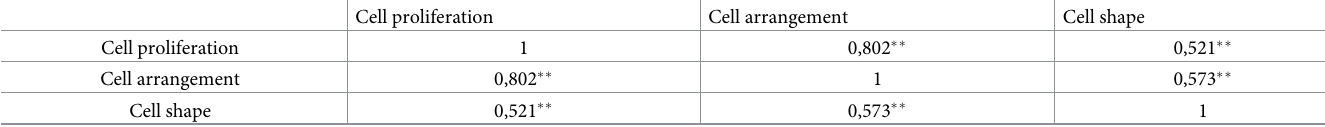
Table 2. Pearson correlation coefficients for different phenotypic parameters at early stages of development. Cell proliferation, cell arrangement and cell shape were evaluated in 65 seedlings of ‘Moniqui’ X ‘Paviot’ (MXP) F1 apricot progeny grafted on ‘Marianna 2624’ one month after